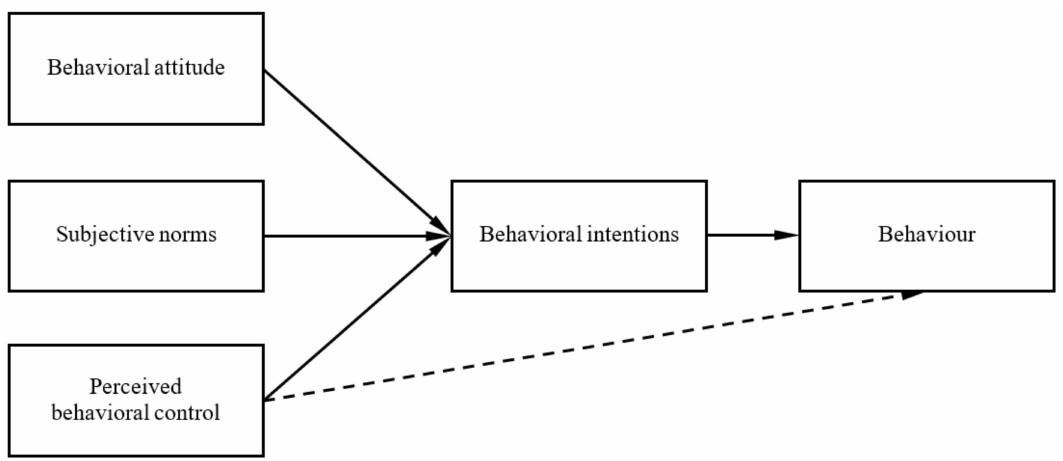
Figure 1. The theory of planned behavior (TPB) model of cancer